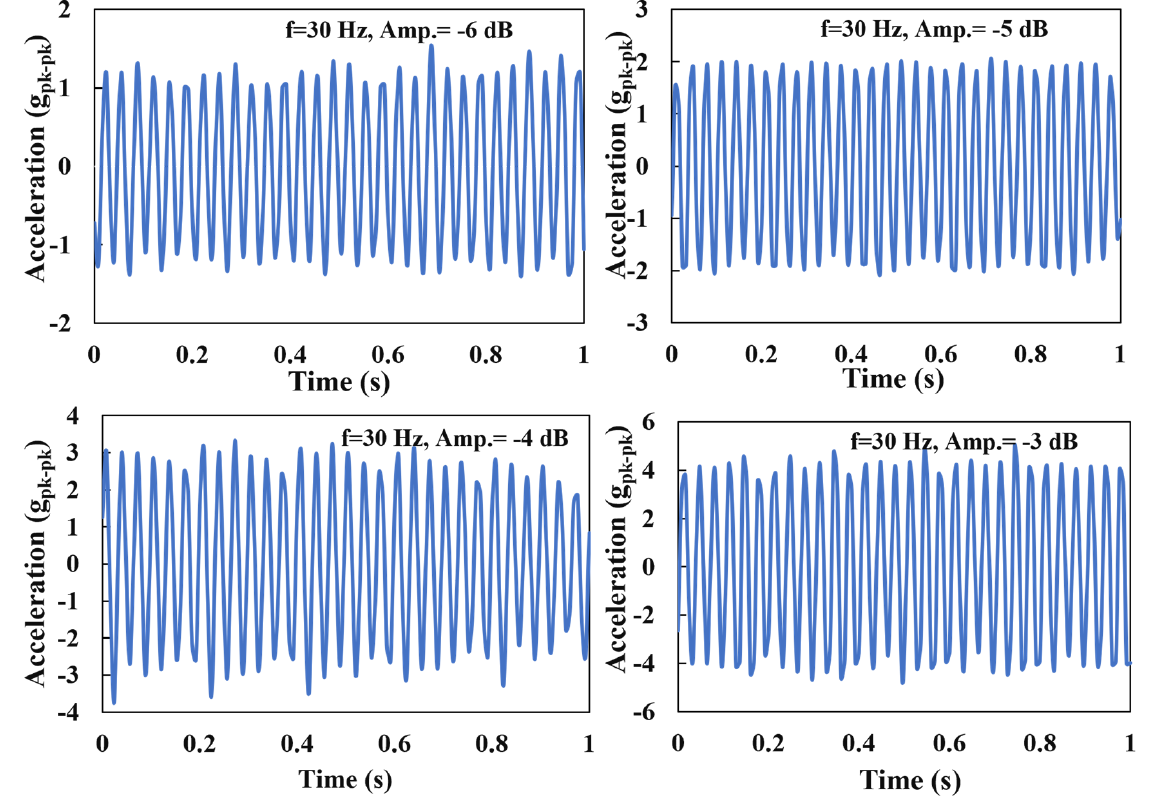
Figure 2. Results of acceleration measurement at 30 Hz and amplitudes ranging from - 6 dB to - 3 dB.